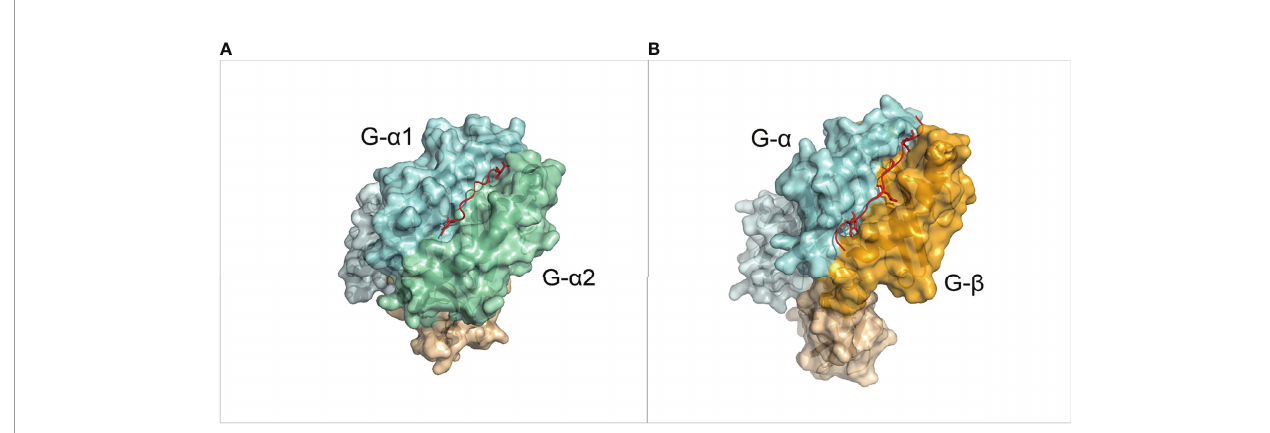
FIGURE 1 | Overview of the MHC molecules. (A) 3D structure of a pMHC-I complex (PDB ID: 1DUZ). The a chain is divided in IMGT de fi ned domains by shades of light blue. The b -2 Microglobulin chain is shown in light orange. The peptide is shown in red. (B) 3D structure of a pMHC-II complex (PDB ID: 1AQD). The alpha chain is divided in IMGT de fi ned domains by shades of light blue. The b chain is divided in IMGT de fi ned domains by shades of orange. The peptide is shown in